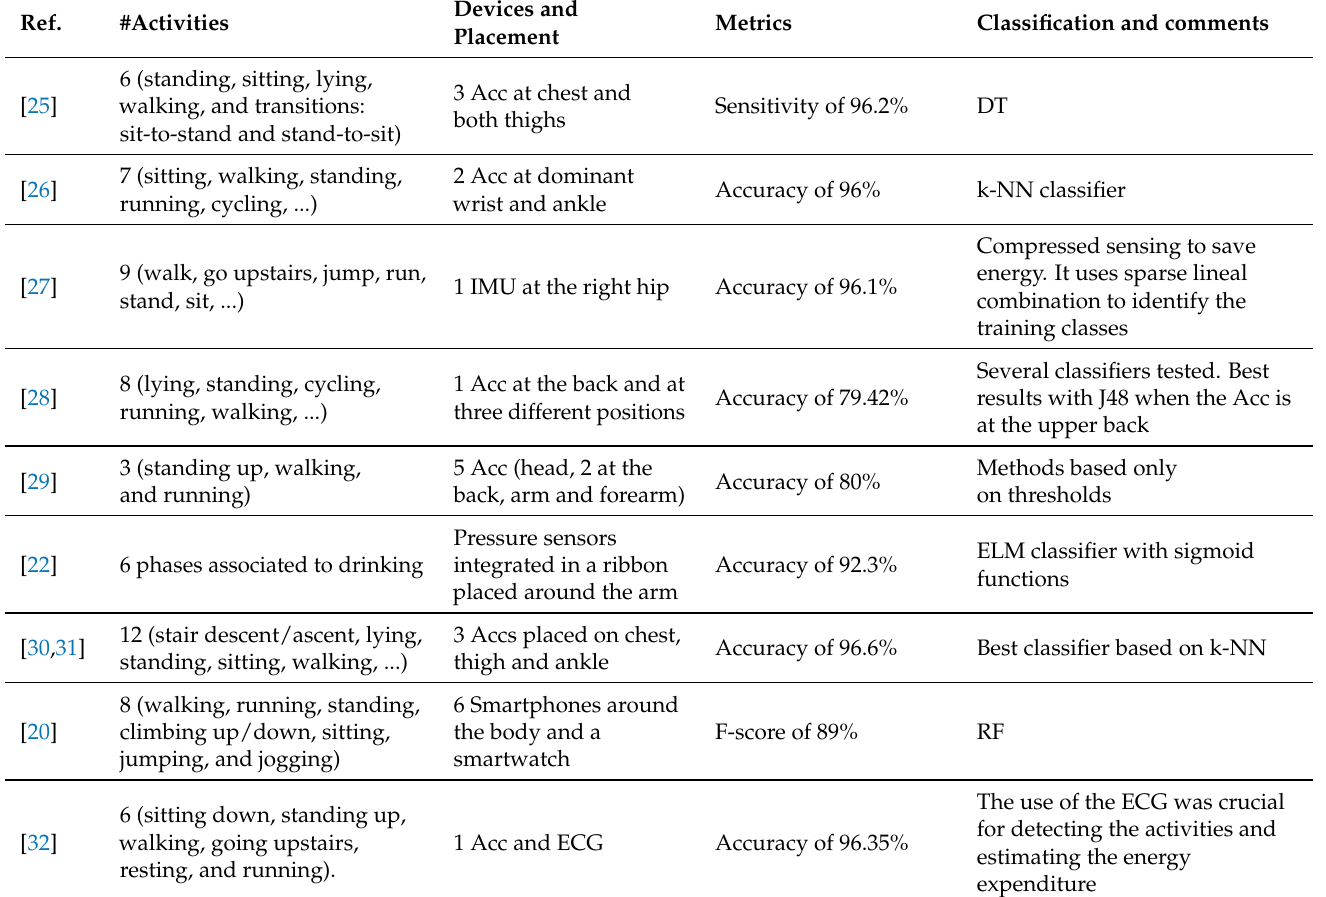
Table 1. Description of selected studies for HMA identification. Some acronyms: accelerometer (Acc), breathing rate (BR), deep belief network (DBN), Decision tree (DT), electrocardiography (ECG), extreme learning machine (ELM), electromyography (EMG), inertial measurement unit (IMU), random forest (RF), support vector machine